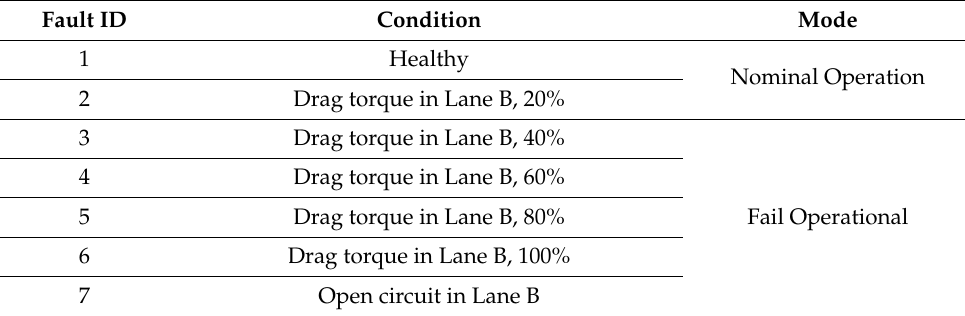
Table 3. List of potential faults and target operation